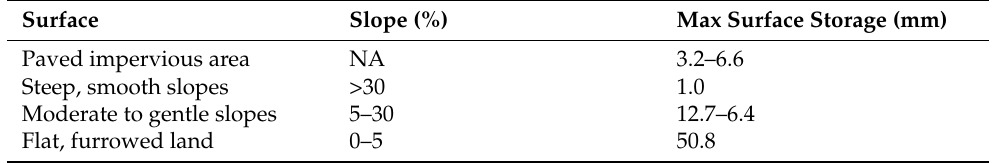
Table 4. Maximum surface storage according to percent slope